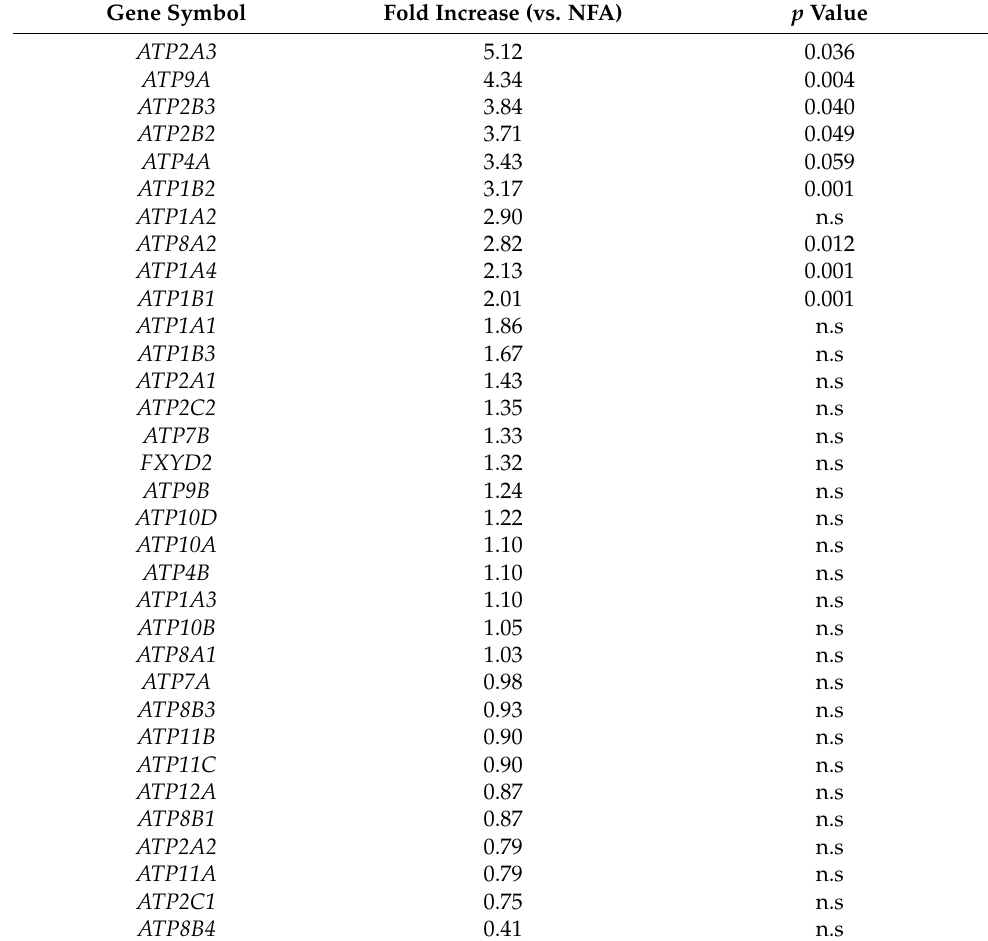
Table 2. The difference of genes related with P type ATPase between aldosterone-producing adenoma (APA) with ATP1A1 mutation and nonfunctioning adrenocortical adenoma (NFA). Gene